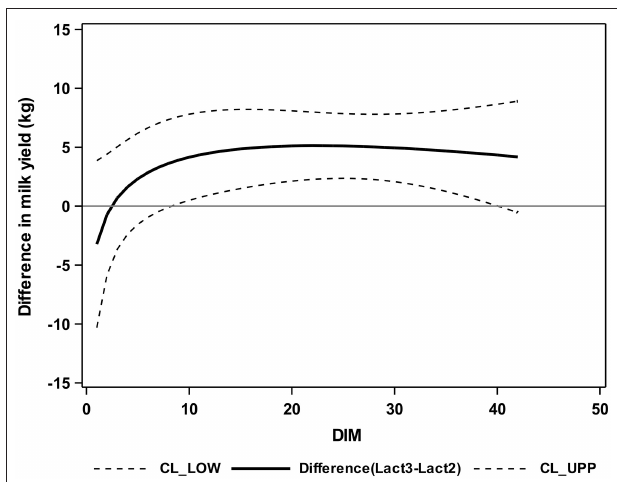
FIGURE 5 | Differences between group Lact2 (lactation 2, n = 3) and group Lact ≥ 3 (lactation 3 or greater, n = 5), least square means, and 95% confidence intervals for the milk yield (kg) of the two groups of German Holstein cows in the first 42 DIM. 0 = parturition; CL_LOW (lower dashed line) = lower confidence limit; CL_UPP (upper dashed line) = upper confidence limit; solid line = difference between